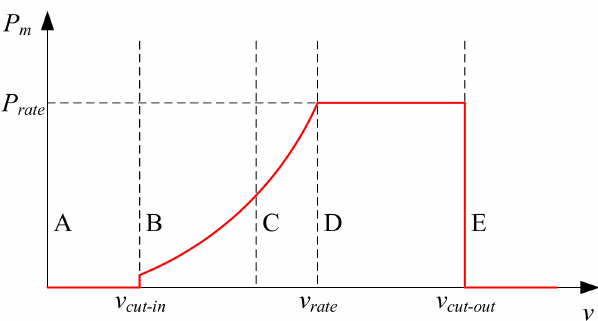
Figure 3. The ideal wind speed-power characteristic curve of the